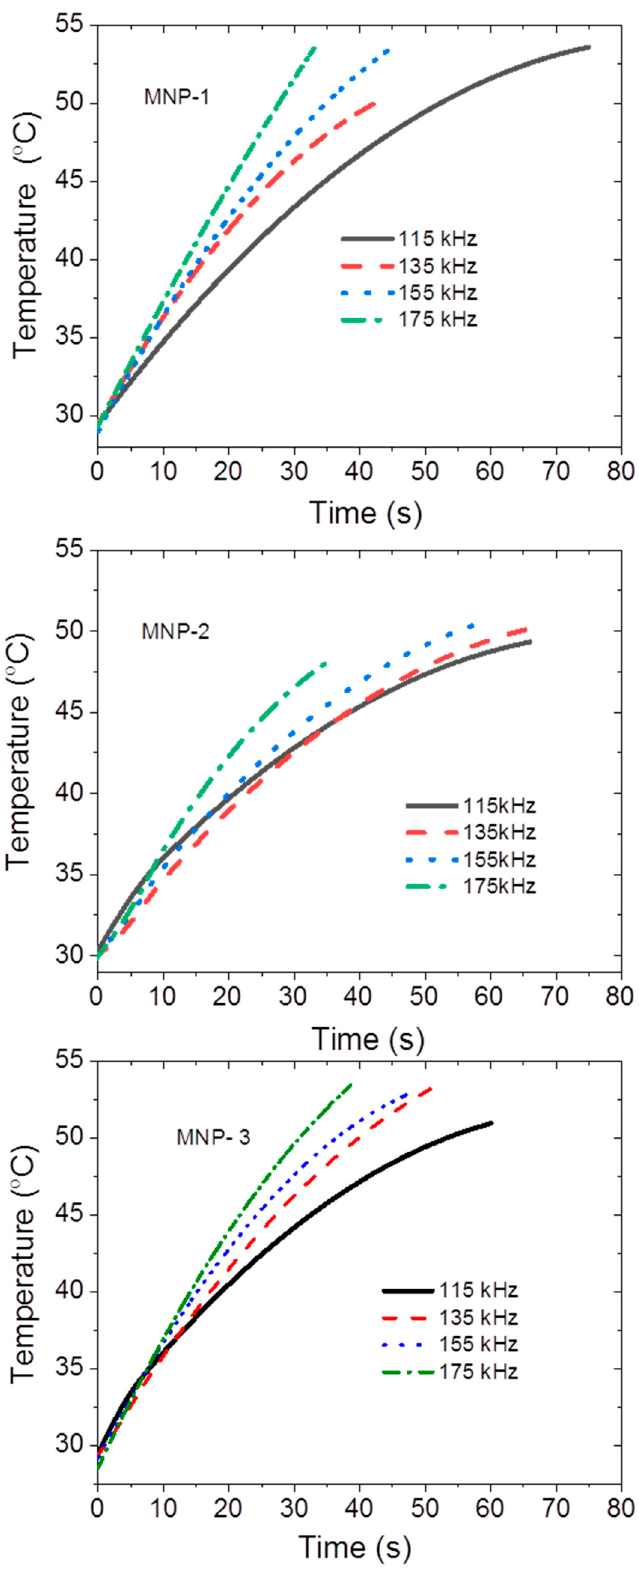
Figure 4. Time dependence of the temperature of the 10 mg/mL suspensions of the investigated nanoparticles after switching on a magnetic field with an amplitude of 12 kA/m and the frequency indicated.